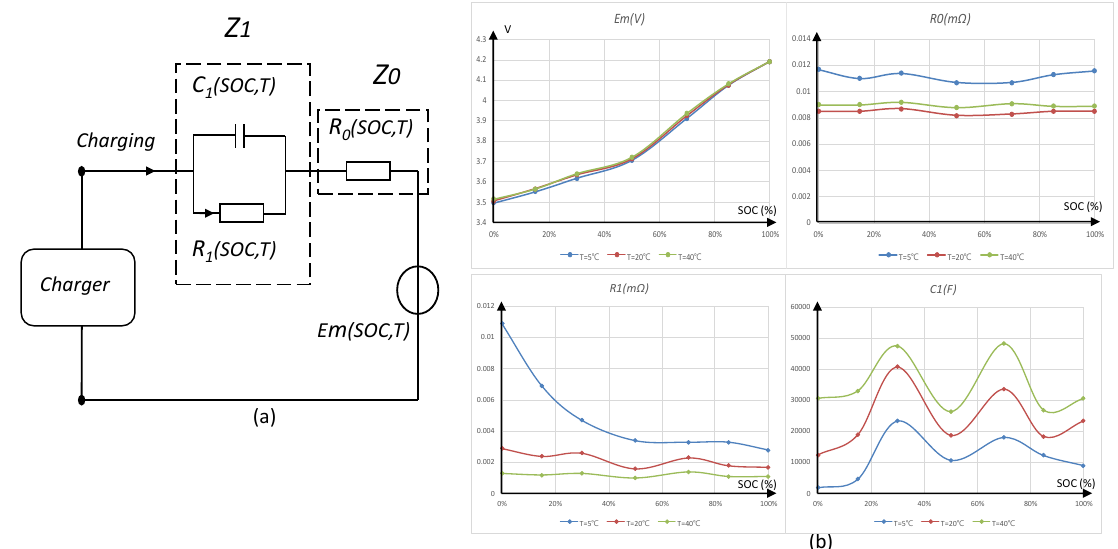
Figure 7. ( a ) Equivalent circuit model, and ( b ) lookup table (LUT) for statically sensed characteristics of the lithium battery cell (X axis: